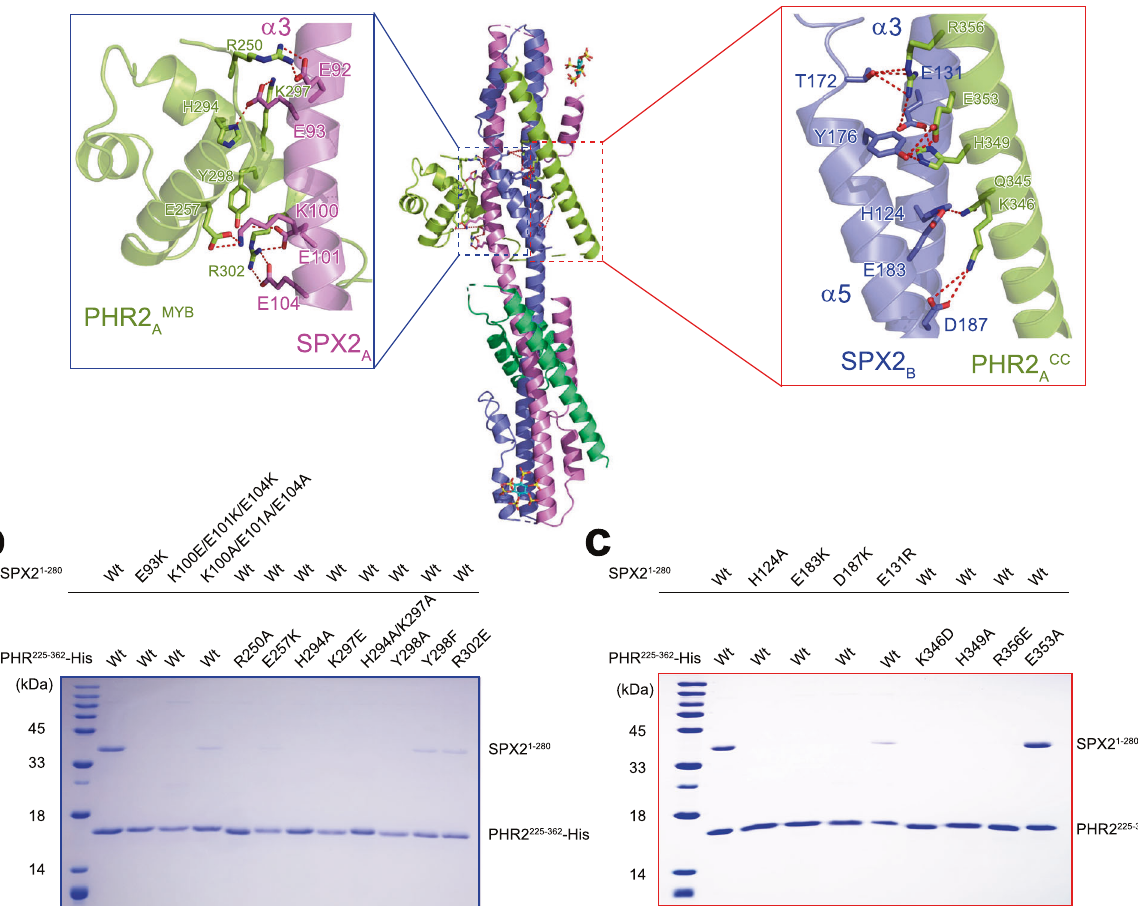
Fig. 3 The recognition of rice PHR2 by the domain-swapped rice SPX2 dimer. a The binding surface of the MYB domain and CC domain of PHR2 A in the domain-swapped SPX2 dimer. The PHR2 protomer A binds to the SPX2 dimer in the same way as protomer B, and only the details of protomer A are depicted. b Co-expression coupled Ni-NTA pull-down assess the interface between PHR2 MYB and SPX2 dimer, and c between PHR2 CC and SPX2 dimer. Experiments were independently repeated three times with similar results. For the pull-down assay, different mutated versions of the full length SPX2 1 – 280 and His-tagged PHR2 225 – 362 were co-expressed in the presence of 1 mM InsP 6